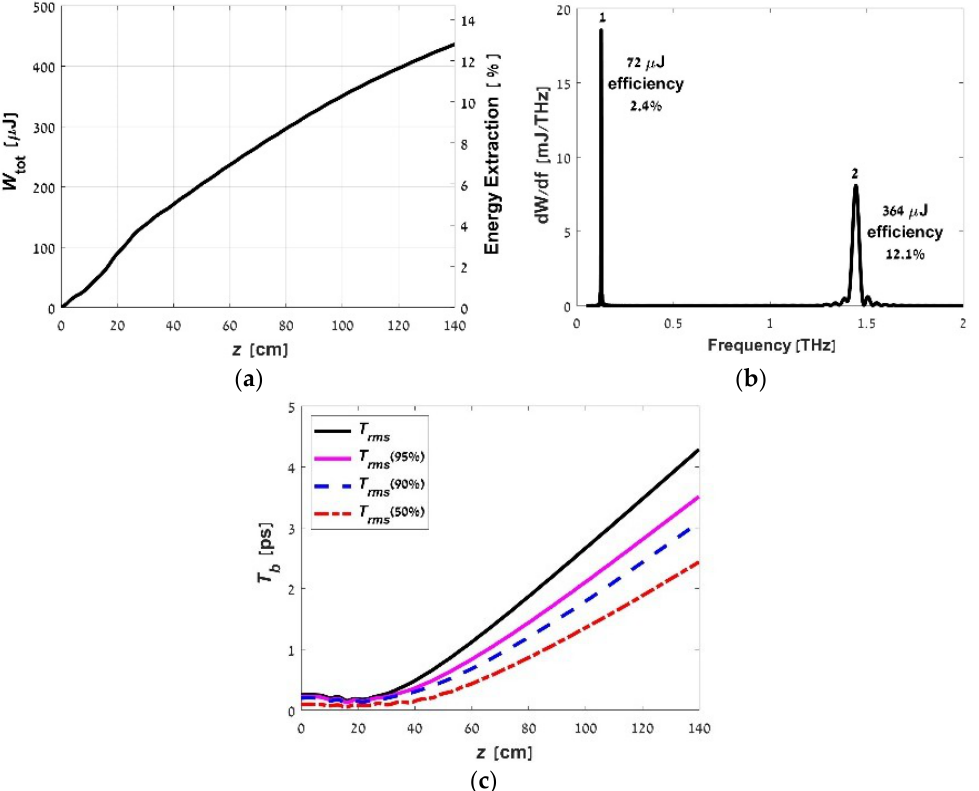
Figure 8. Undulator CSR of a bunch with a diameter of 1 mm, an initial duration of 0.25 ps, a charge of 0.5 nC, and a particle energy of 6 MeV in the regime of simultaneous excitation of low- and high-frequency waves: ( a ) radiated energy, ( b ) emission spectrum, and ( c ) change in the rms bunch durations.